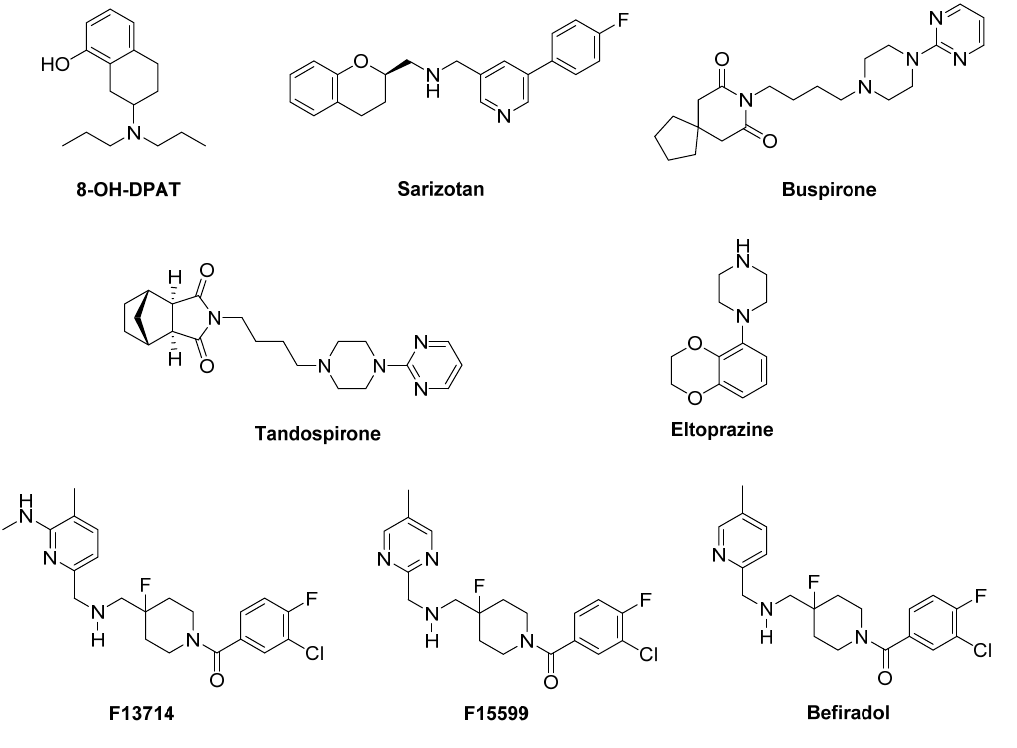
Figure 3. 5 ‐ HT 1A R agonists. Figure 3. 5-HT 1A R